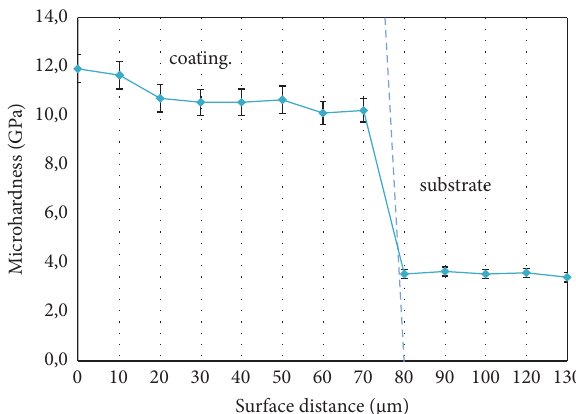
Figure 9: Graph of the depth hardness distribution of the gradient coating (57-65-73) based on Cr 3 C 2 -NiCr obtained by detonation spraying.